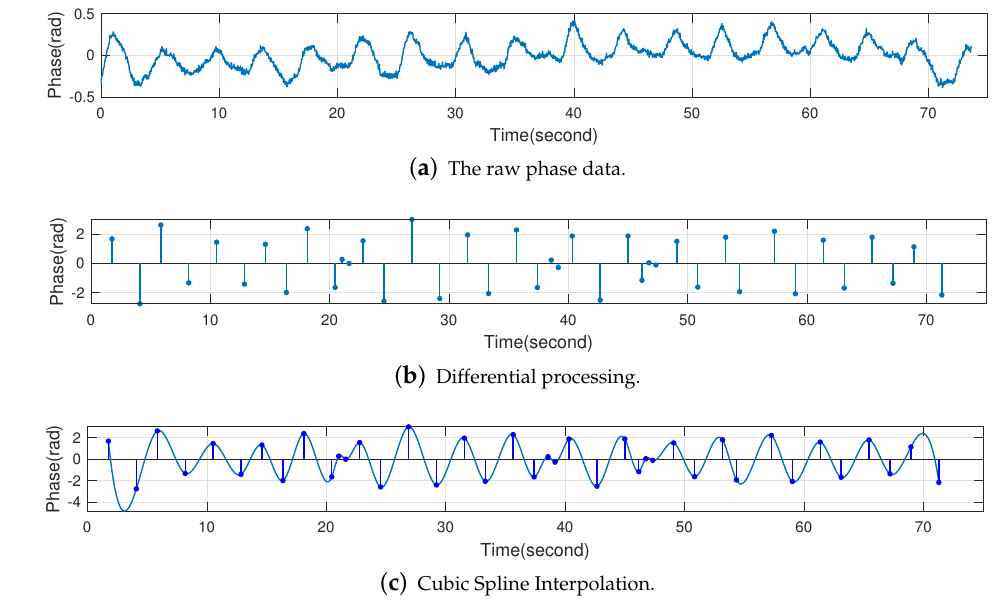
( c ) Cubic Spline Interpolation. Figure 13. Differential processing and Cubic Spline